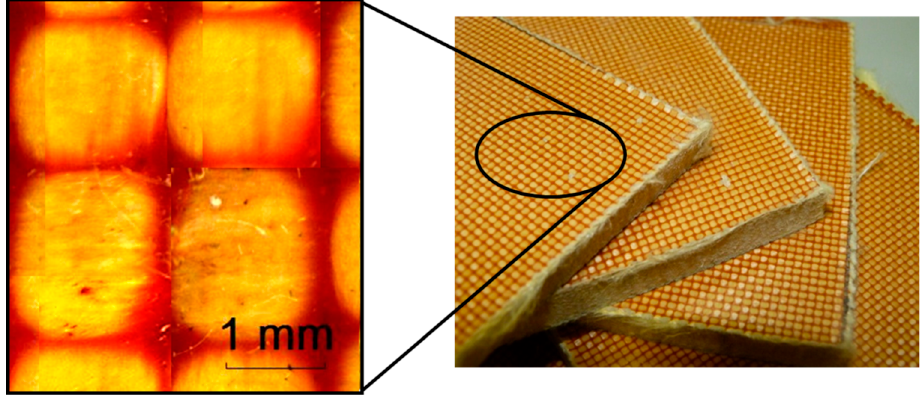
Figure 1. K129 aramid composite used in this work and description of the size of the fibres.